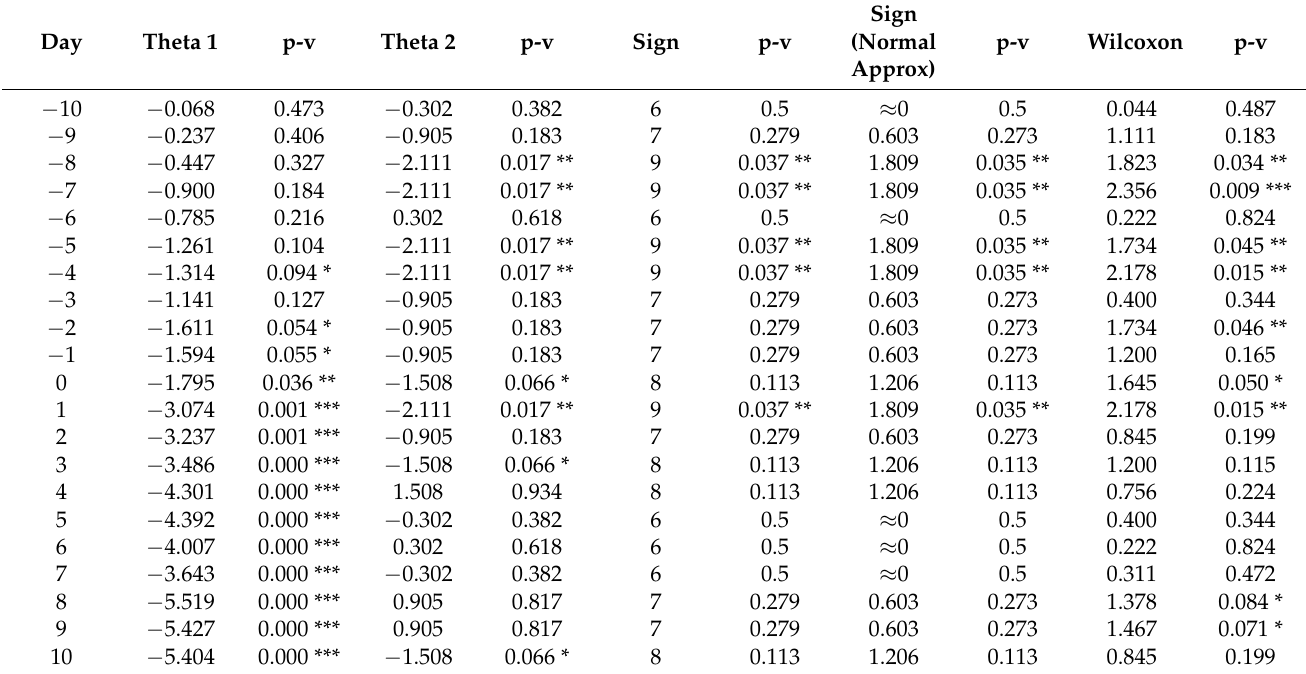
Table 7. Event study test, event